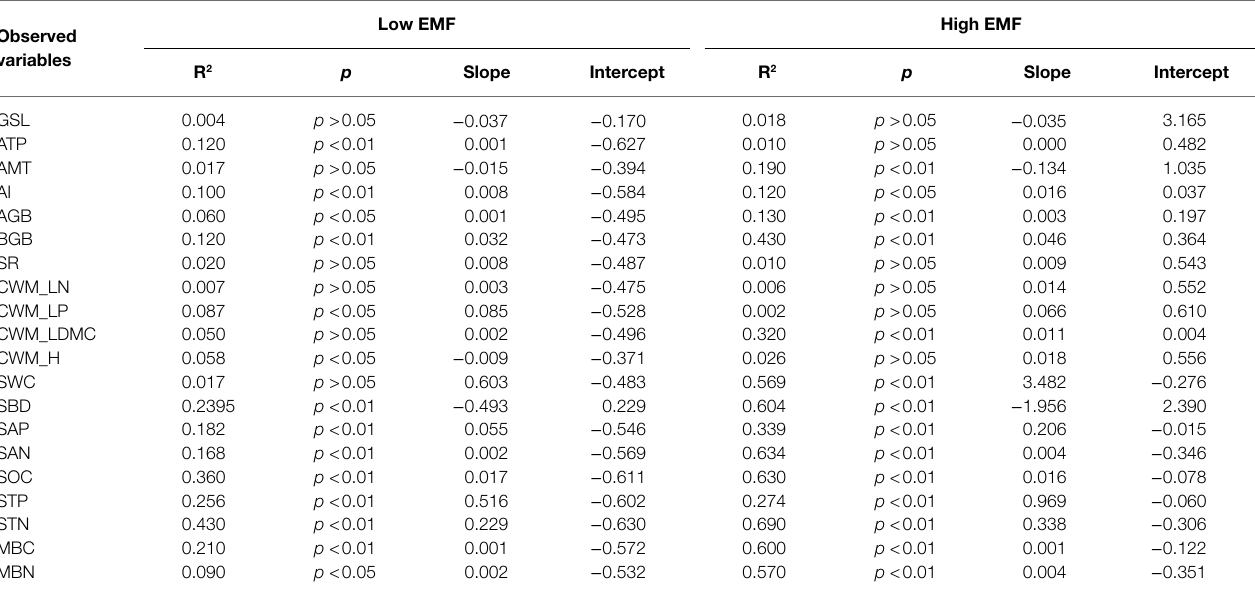
TABLE 1 | Results of the general linear regressions among low and high ecosystem multifunctionality (low EMF and high EMF) and influencing factors. Observed